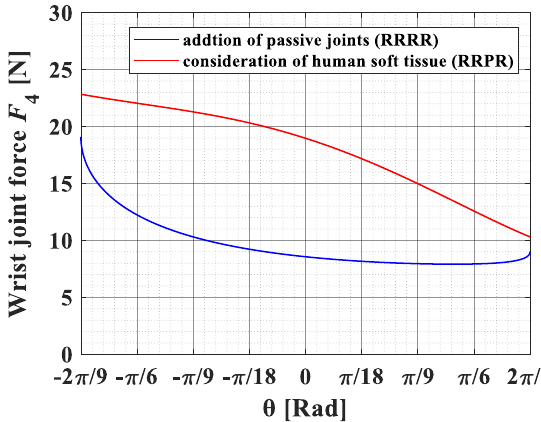
Figure 16. Wrist force comparisons with the addition of passive joints (RRRR) and consideration of human soft characteristics (RRPR).